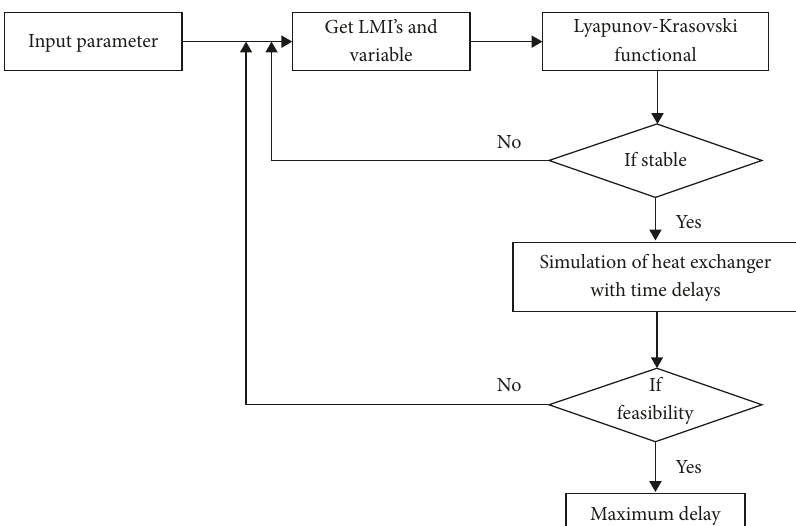
Figure 2: The LMI condition-based determination of the viability of a temperature network control system with